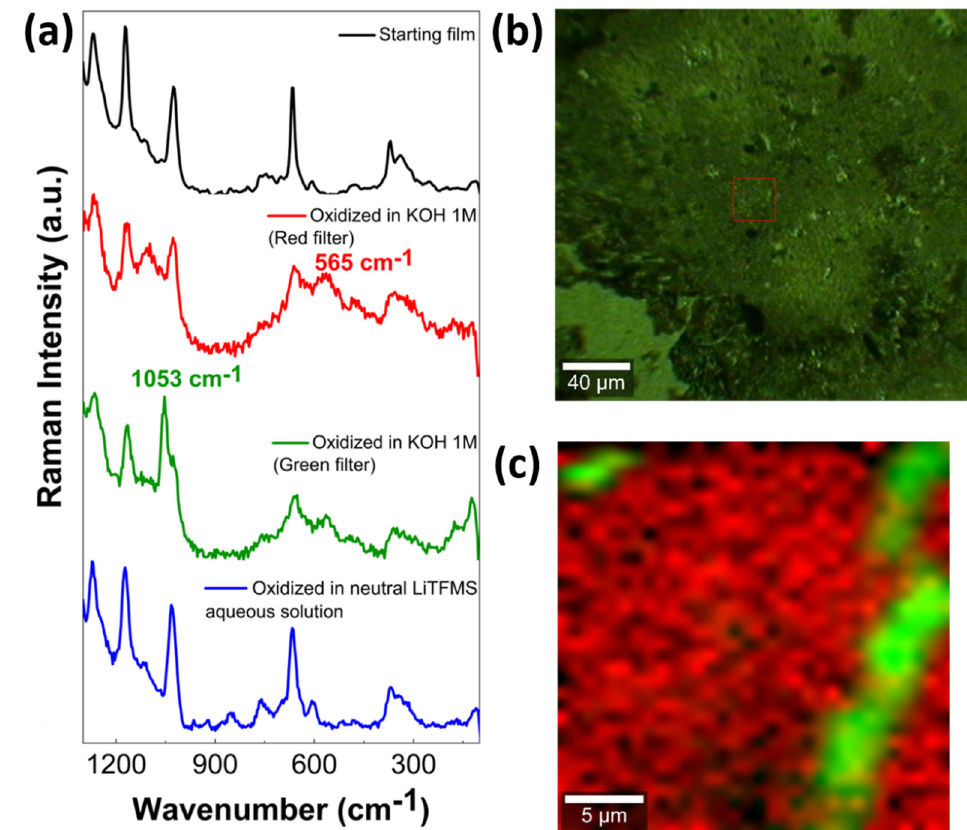
Figure 9. ( a ) Raman spectra of TRuCoTPyPz films on FTO electrodes before (black line) and after electrocatalytic oxygen evolution reaction in 1 M KOH in the red and green filters of the Raman mapping. The blue line represents the Raman spectra of the TRuCoTPyPz film oxidized in neutral lithium triflate aqueous solution in the absence of oxygen; ( b ) optical microscopy image of the TRuCoTPyPz film on FTO glass substrate; ( c ) Raman spectral mapping of the marked region in ( b ).